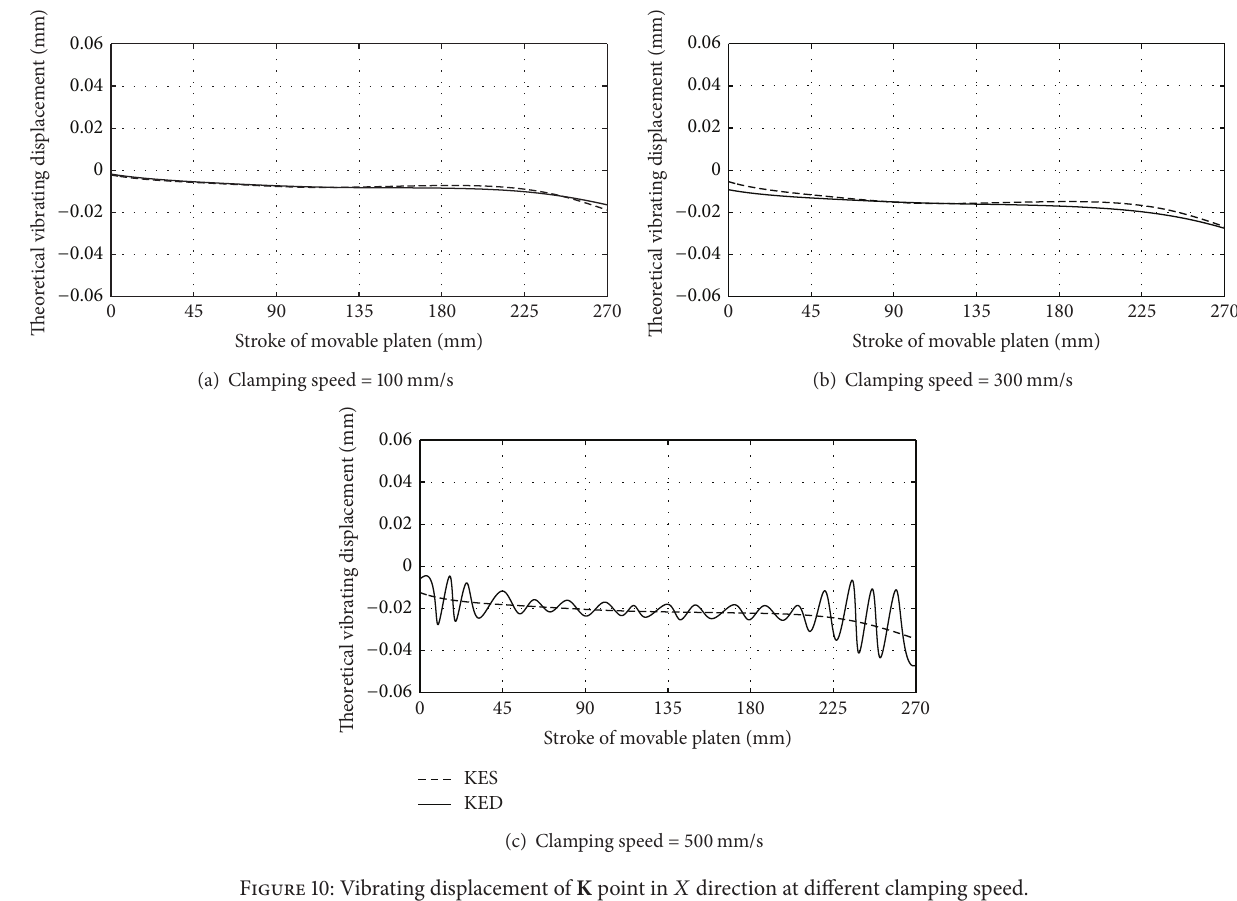
curve changes suddenly with a larger vibrating dis- placement, due to the larger elastic deformation of the